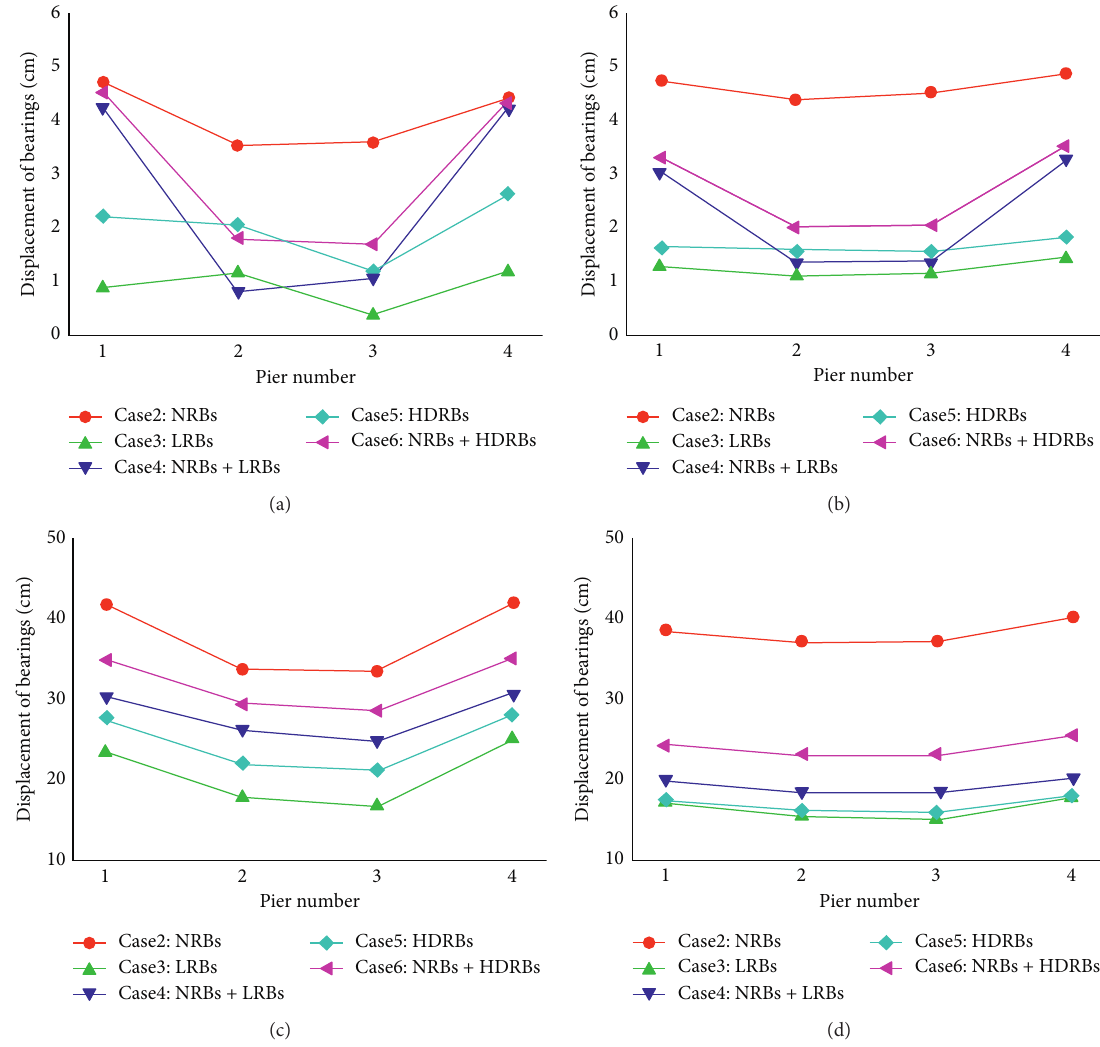
Figure 8: Displacement of bearings in different cases: (a) longitudinal displacement under the action of small earthquake; (b) lateral displacement under the action of small earthquake; (c) longitudinal displacement under the action of large earthquake; (d) lateral dis- placement under the action of large